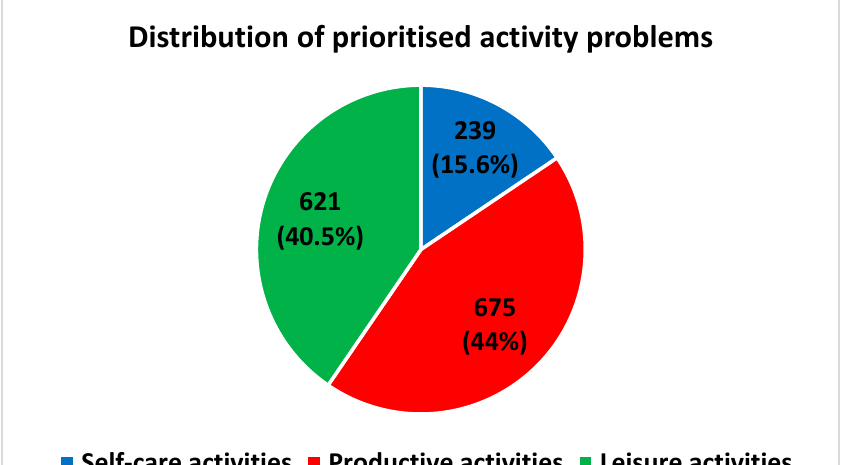
Figure 4. Distribution of reported activity problems within overall COPM categories: self-care ac- tivities (blue), productive activities (red) and leisure activities (green). Frequency ( n ) and relative frequency (%) reported. COPM data is based on 430 patients.